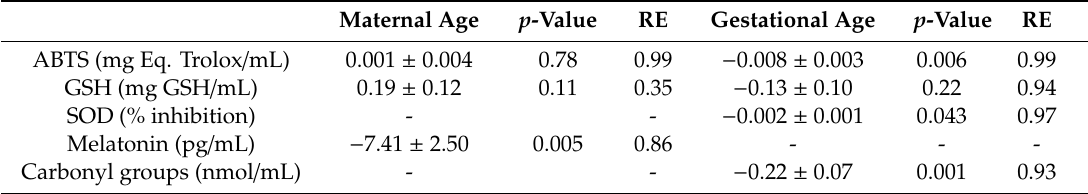
Table 2. Linear regression models with mixed random-e ff ect by day of